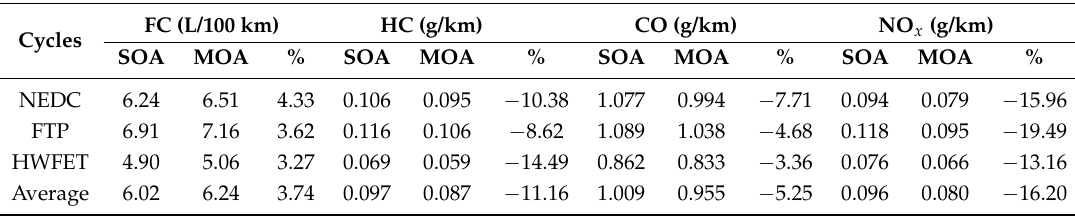
Table 2. Experimental results of the two